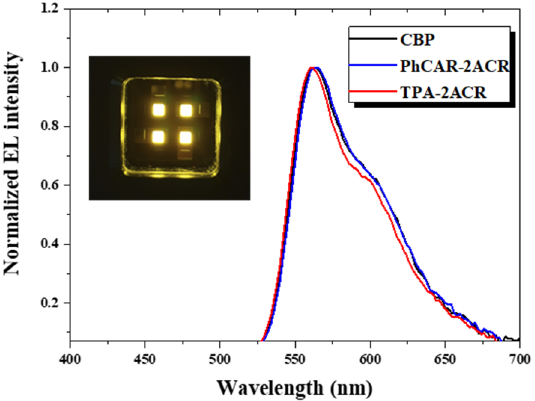
Figure 7. Electroluminescent spectra of yellow phosphorescent OLEDs. Table 2. Device characteristics of PhCAR ‐ 2ACR and TPA ‐ 2ACR ‐ based phosphorescent devices with TAPC and CBP ref ‐ erence devices.